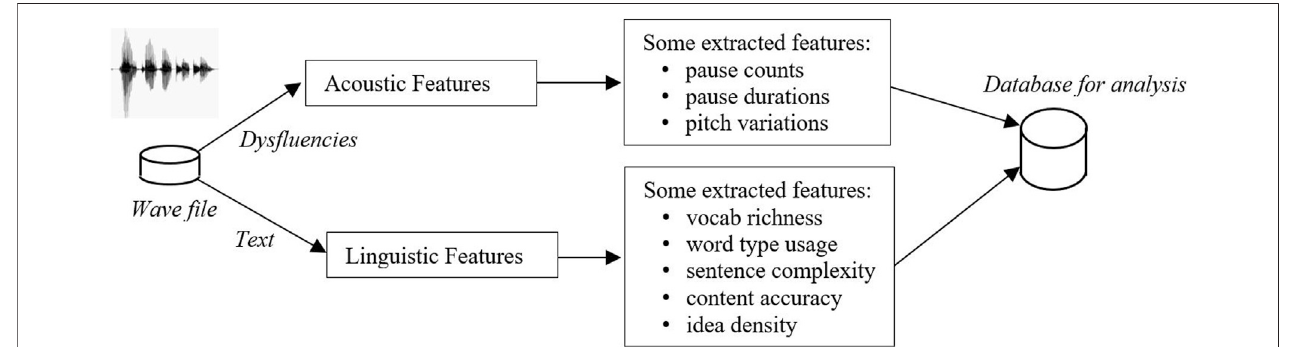
FIGURE 1 | Block diagram for creating database of features.